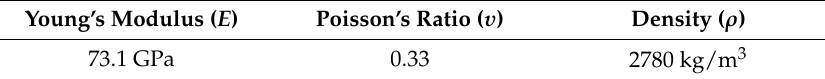
Table 1. Material properties of 2024-T3 aluminum.